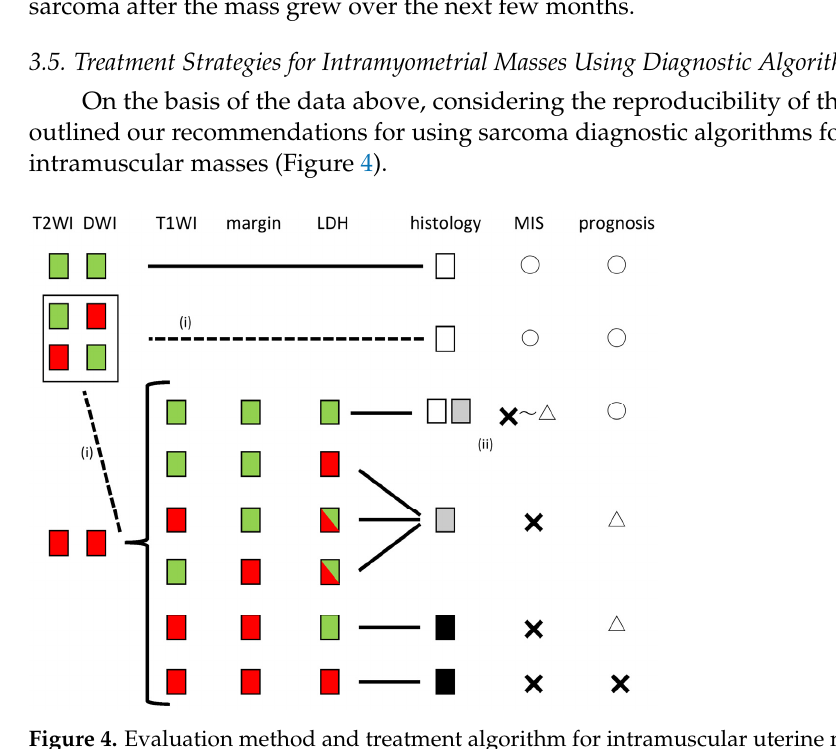
Figure 4. Evaluation method and treatment algorithm for intramuscular uterine masses. Red: high T2WI, high DWI, high T1WI, unclear margin, and high LDH; green indicates low values. For histology, white indicates leiomyoma, grey indicates s/o sarcoma, and black indicates sarcoma. MIS, minimally invasive surgery. (i) Normally, a low T2 or DWI indicates no sarcoma, but when evaluated by a non-gynecologic MRI specialist, either or both may be positive. However, when evaluated by a non-gynecological MRI specialist, if either of them is positive, it is safe to treat it as a case where both are positive. (ii) If both T2WI and DWI are high and the other factors are negative, the result will